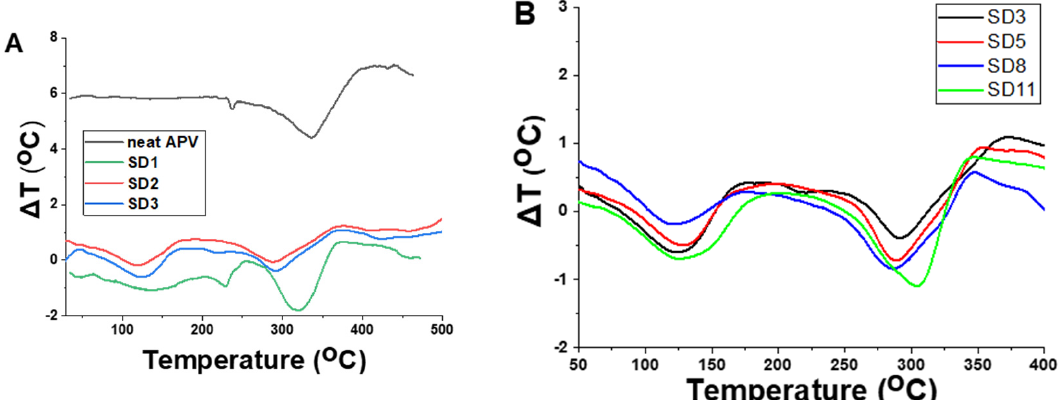
Figure 5. DTA thermograms for the polymer films ( a ) neat APV, SD1, SD2, SD3 and ( b ) SD3, SD5, SD8, SD11 .